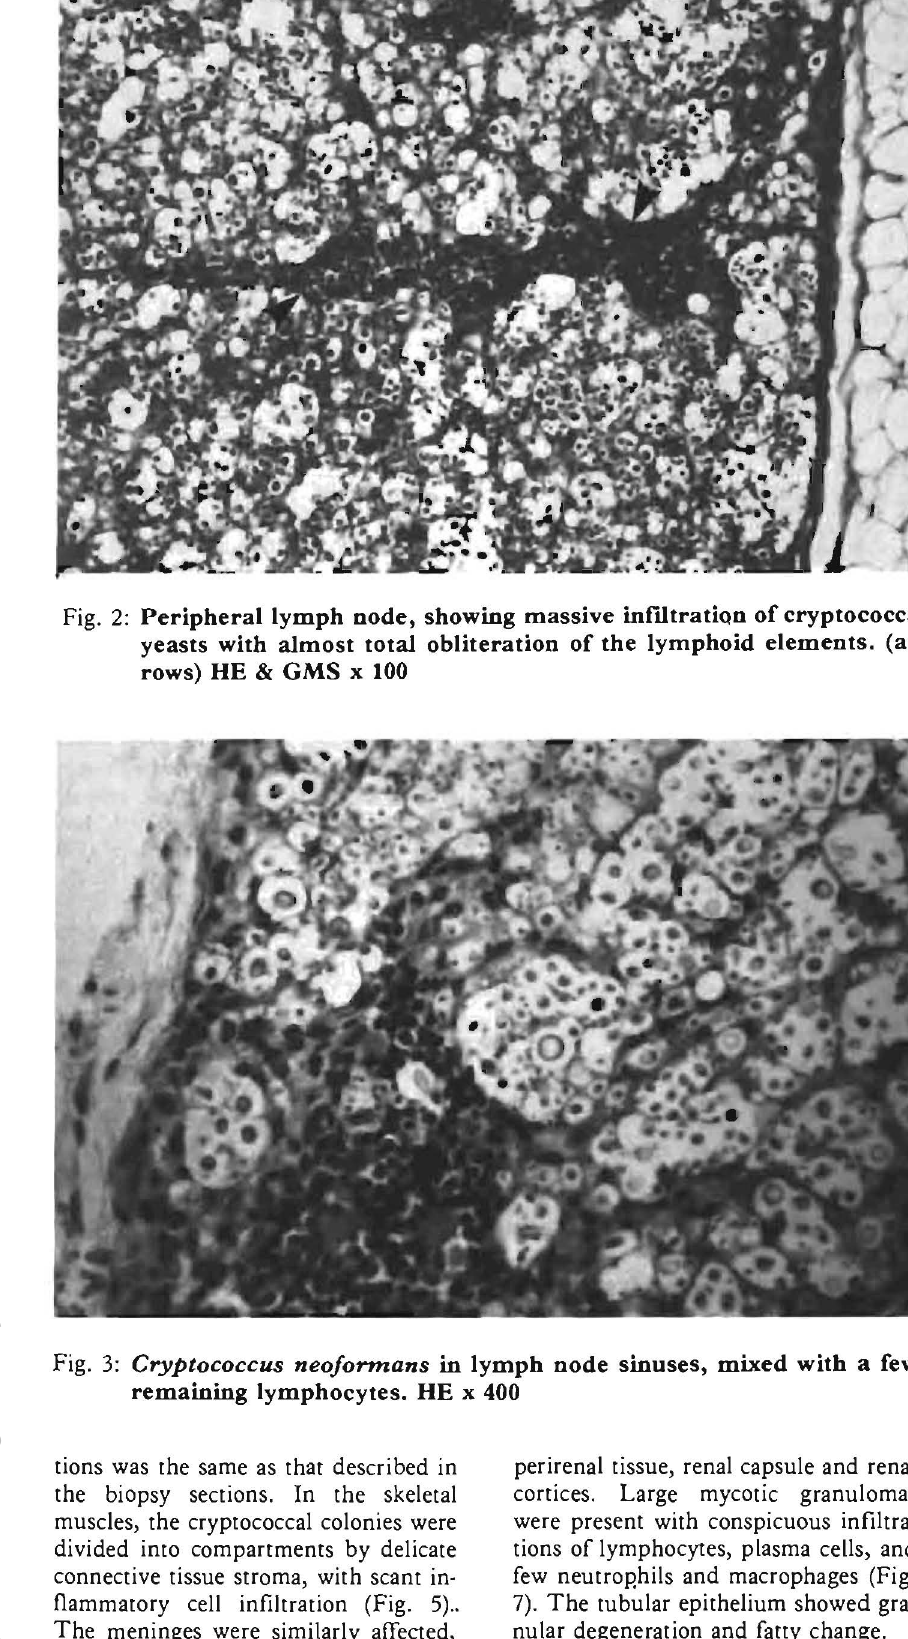
Fig. 3: Cryptococcus neoformans in lymph node sinuses, mixed with a few remaining lymphocytes. HE x